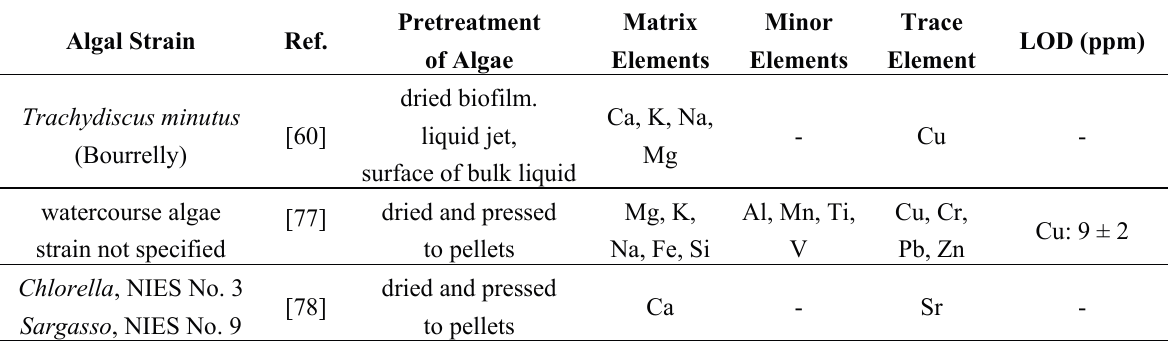
Table 1. The list of articles focused on the analysis of algae employing